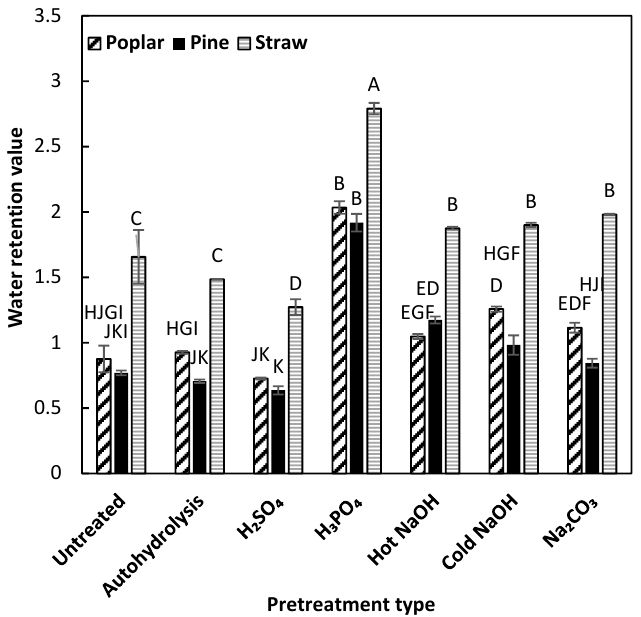
Figure 2. Water retention value of untreated and pretreated substrates using a centrifuge method, considerable differences among the samples are seen by different letters by ANOVA test.